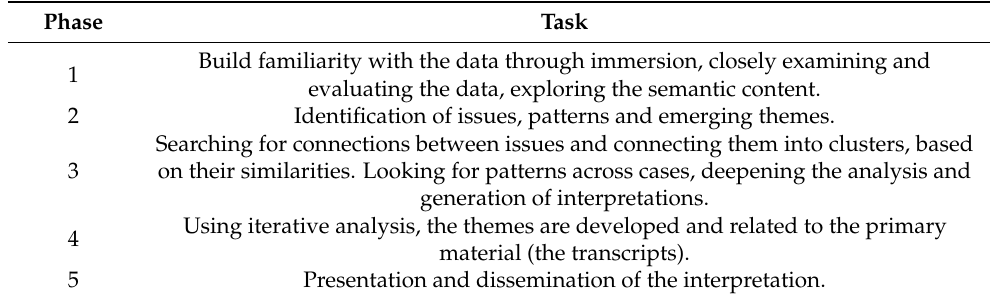
Table 1. Phases of IPA